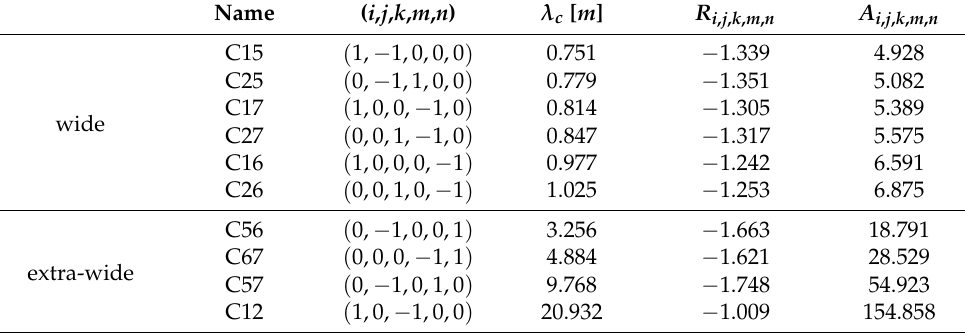
Table 4. Wide-lane combination of